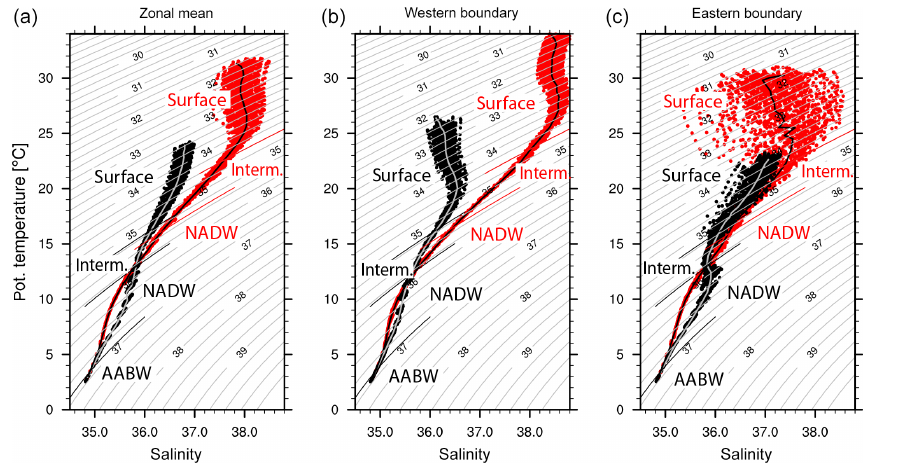
Figure A1. Temperature–salinity diagrams at 26 ◦ N for the historical simulation (1850–1950 in black) and RCP 8.5 (2200–2300 in red) for (a) zonal mean, (b) western boundary, and (c) eastern boundary temperatures and salinities. Water masses show the surface, intermediate, North Atlantic Deep Water (NADW) and Antarctic Bottom Water (AABW). The mean of the temperature–salinity diagrams averaged over density layers is shown in grey and black.